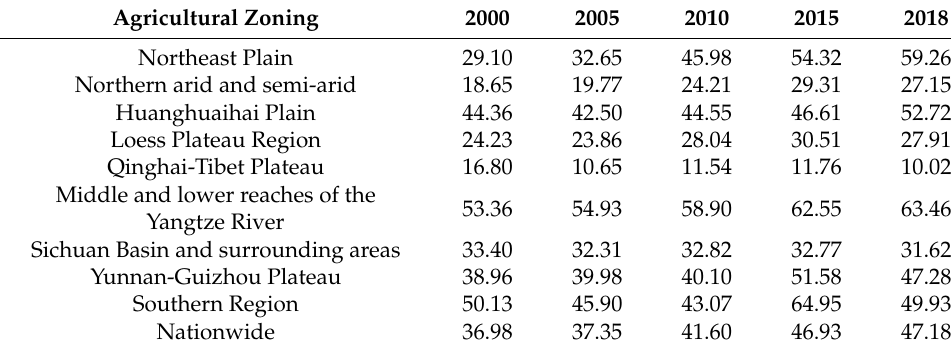
Table 2. GP rate for nine agricultural